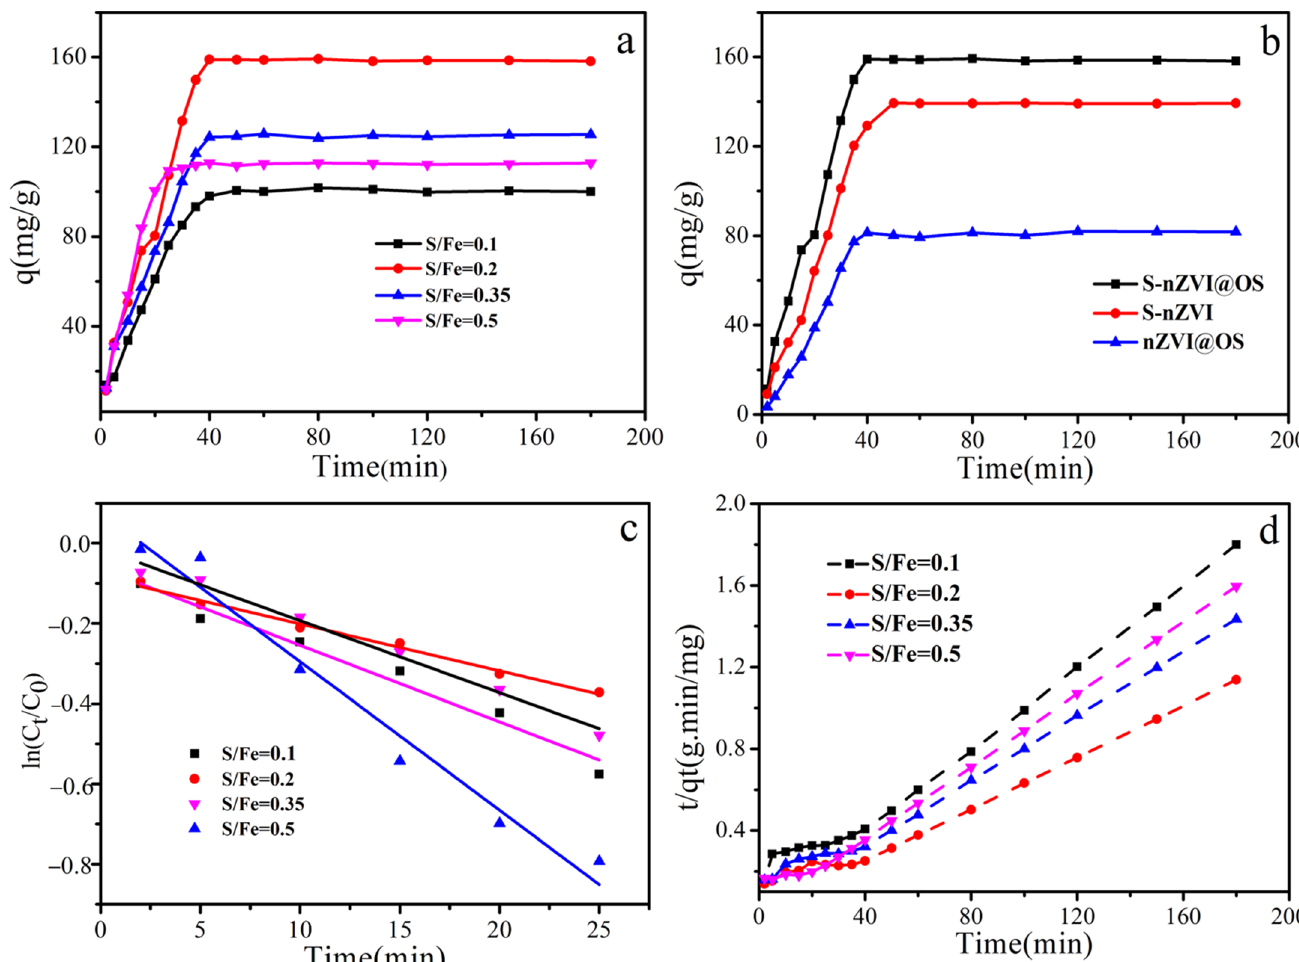
Figure 5. ( a ) The adsorption kinetics of Cr (VI) with different S/Fe ratios; ( b ) the adsorption kinetics of S-nZVI, nZVI@OS and S-nZVI@OS; ( c ) Liner polts of lnC t /C 0 versus T; ( d ) pseudo-second-order dynamics diagram. Table 1. Kinetic parameters of Langmuir-Hinshelwood first-order kinetics model and pseudo- second-order kinetics model of S-nZVI@OS with different S/Fe ratios.